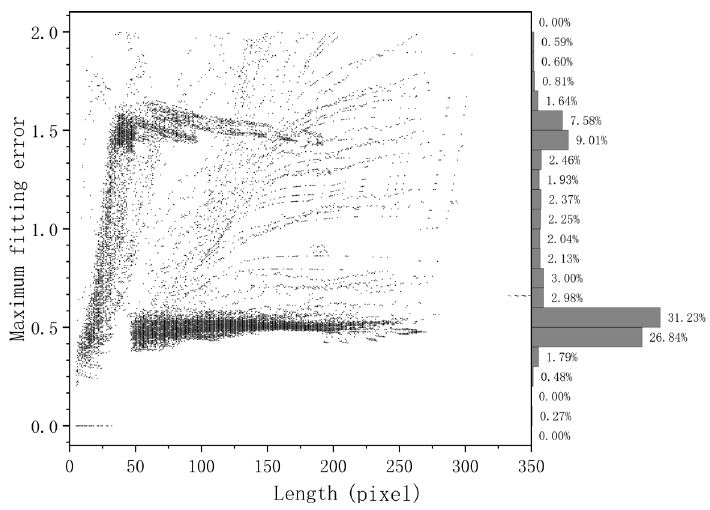
Figure 17. Contour segment length and its maximum fitting error distribution diagram.